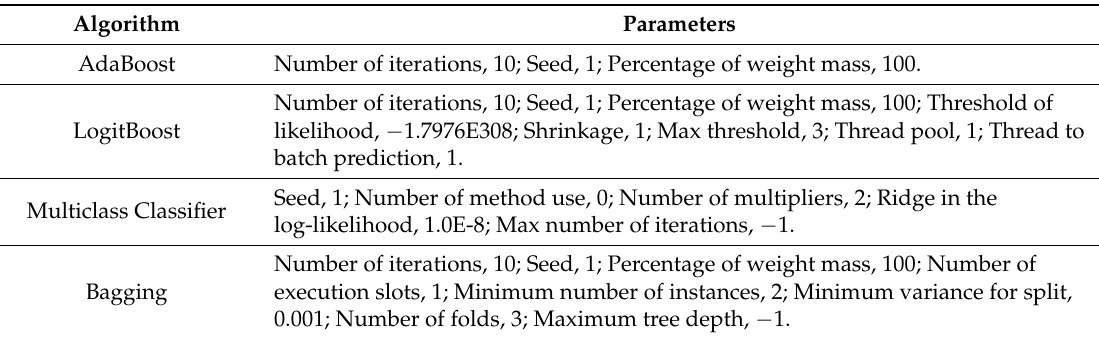
Table 2. Calculated parameters of the algorithms used in this study.